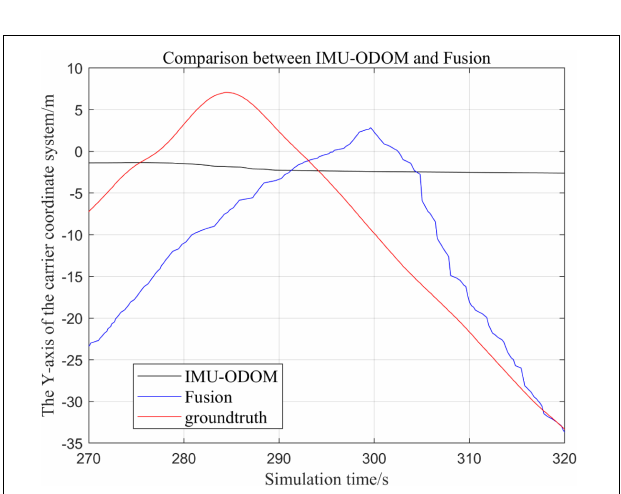
FIGURE 9 | Zoomed-in comparison of the z -axis local trajectories of the fusion algorithm and the MSCKF_VIO algorithm.